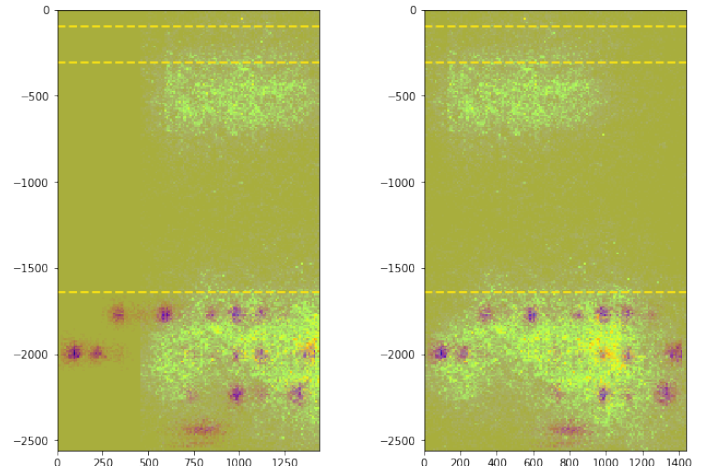
Figure 4. Keyboard area covered visually and by touch, in the original dataset ( left ) and after shifting at the optimal point ( right